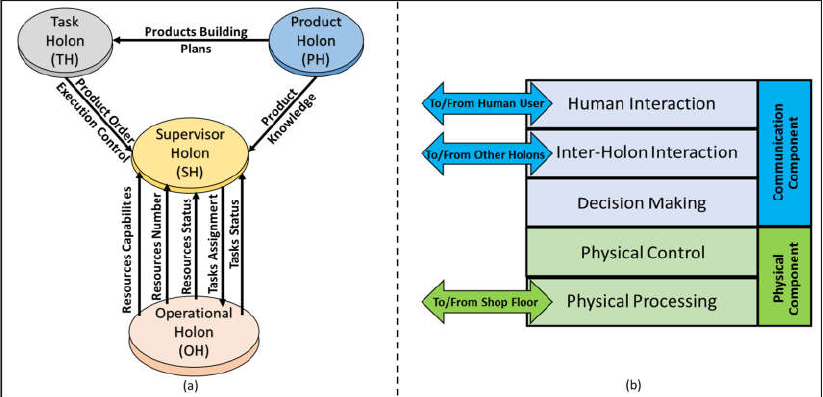
Figure 1. ( a ) ADACOR (ADAptive holonic COntrol aRchitecture) Model; ( b ) Holon Generic